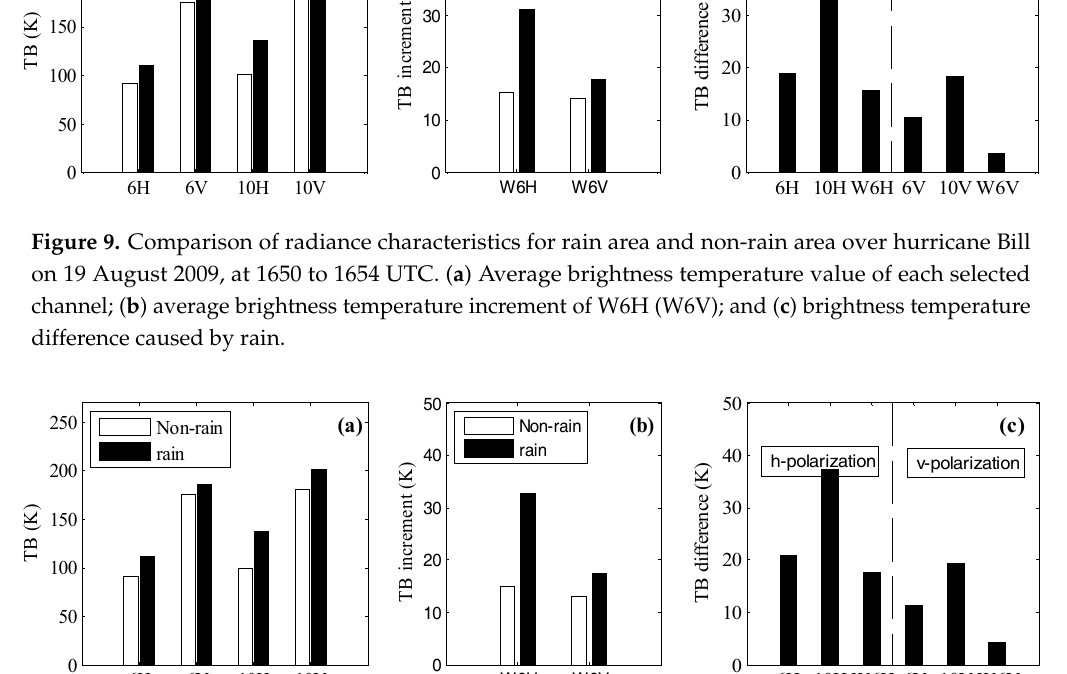
Figure 9. Comparison of radiance characteristics for rain area and non-rain area over hurricane Bill on 19 August 2009, at 1650 to 1654 UTC. ( a ) Average brightness temperature value of each selected channel; ( b ) average brightness temperature increment of W6H (W6V); and ( c ) brightness temperature difference caused by rain.